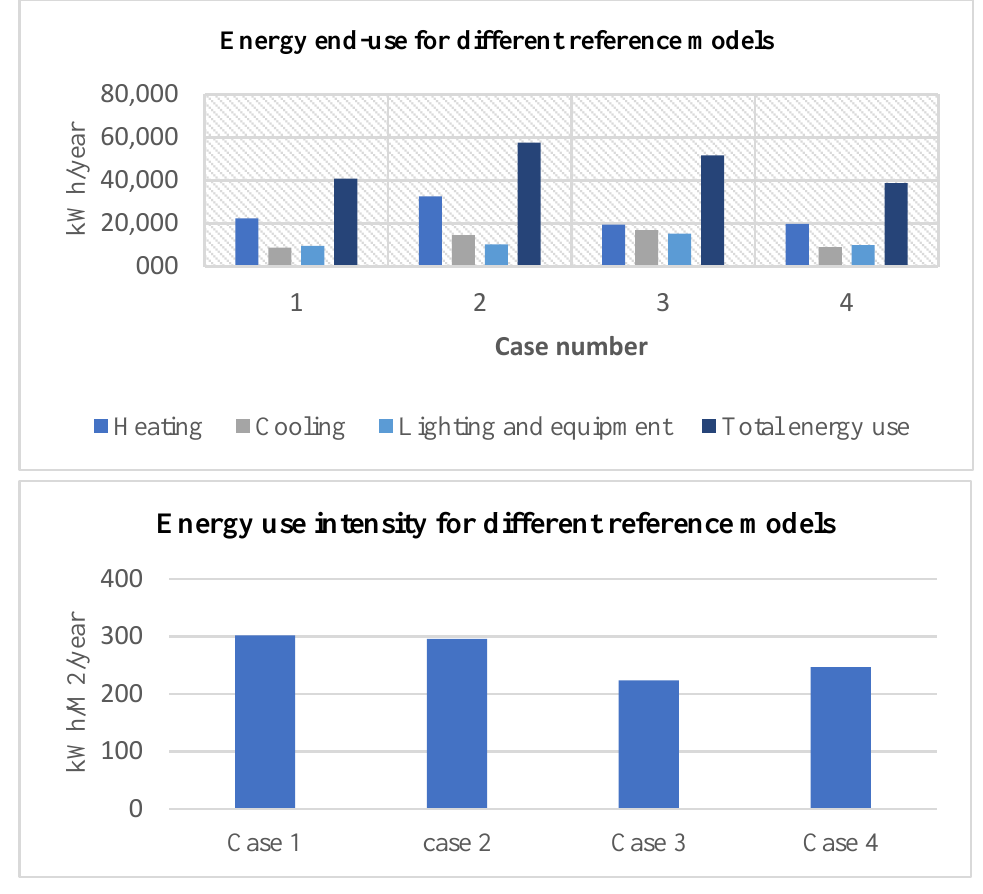
Figure 5. Validation of the calibration based on hourly and annual actual and simulated results.